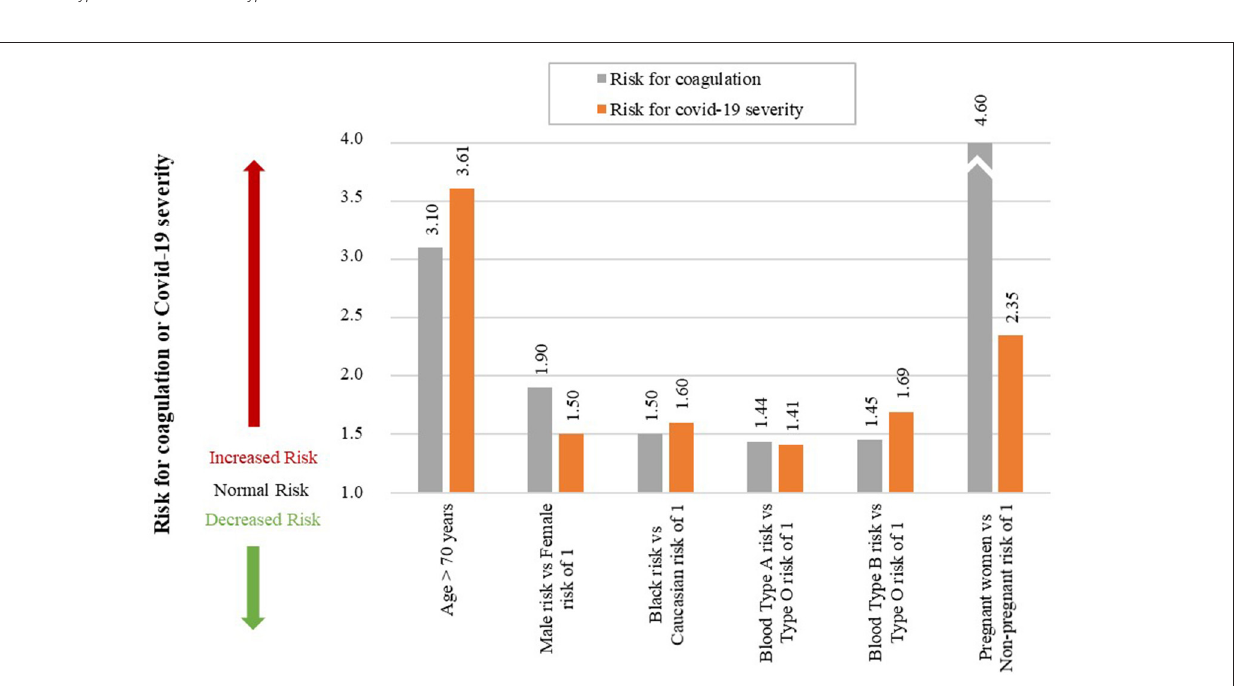
FIGURE 7 | Qualitative comparison of risk factors between coagulation and Covid-19 severity. (An accurate quantitative comparison is not possible, mostly due to differences in study design and size). Covid-19 data also indicate that males have a higher risk of Covid-19 mortality than females, with a RR of 1.50 (60), see Figure 7 . The increased risk of coagulation due to gender for individuals older than 45 years could be one reason for this increased Covid-19